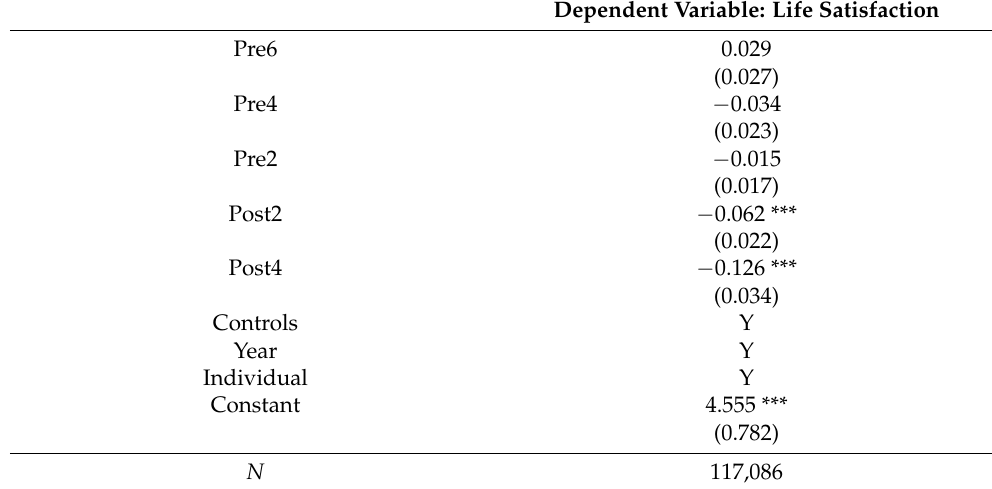
Table A1. Event study